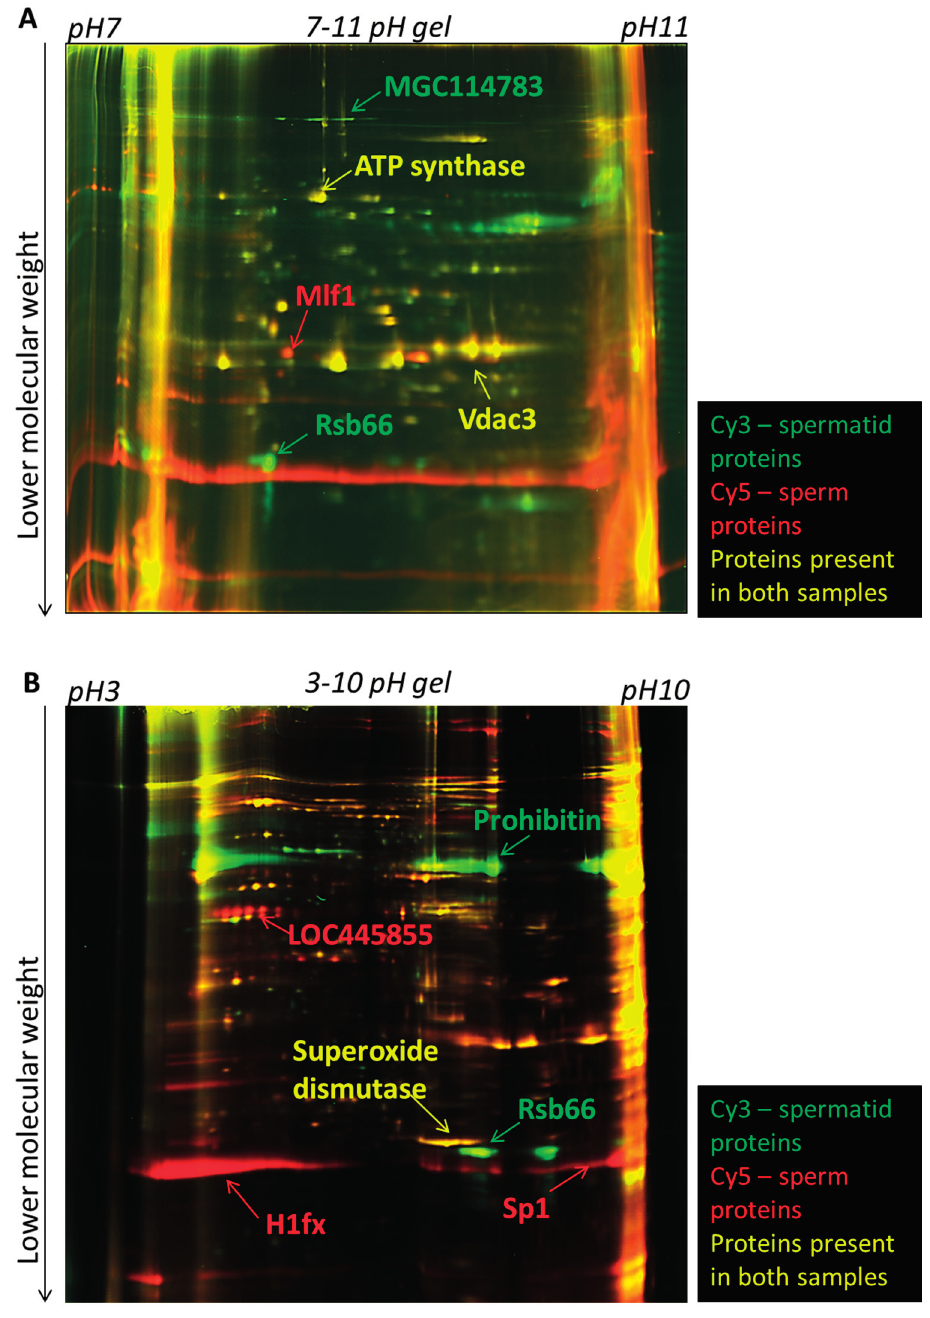
Figure 2. 2D-DIGE electrophoresis of proteins isolated from sperm and spermatids. Proteins isolated from spermatids and sperm were labelled with Cy3 (green) and Cy5 (red) dyes, respectively, and subsequently separated in two dimensions. Examples of sperm- and spermatid-specific proteins identified are indicated with arrows: red arrows for sperm-specific proteins and green arrows for spermatid-specific proteins. ( A ) Laser scanned image of a gel with the proteins separated in pH range 7–11 (basic range); ( B ) Laser scanned image of gel with proteins separated in the pH range 3–10 (broad